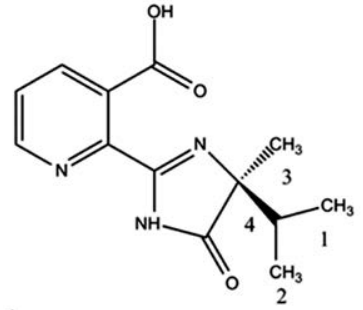
Figure 2: Scheme of photocatalytic ozonation reactor used for im- azapyr